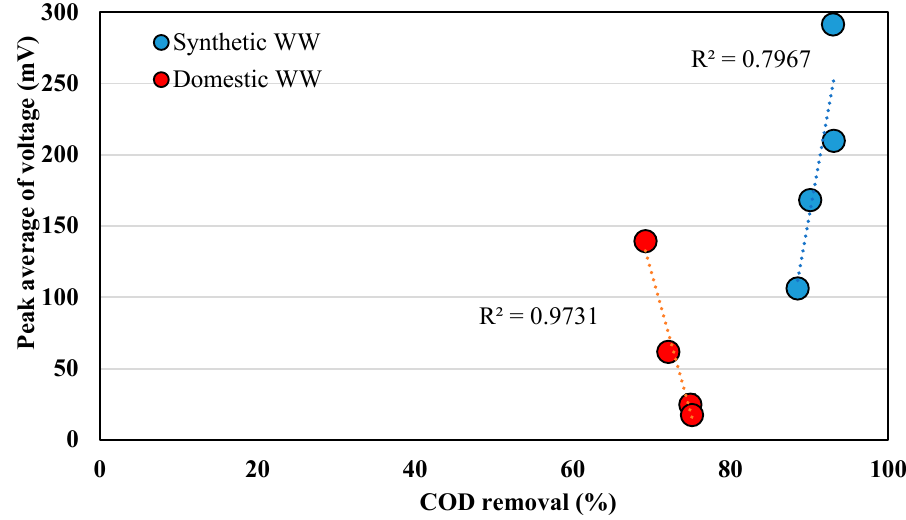
Figure 4. Correlation between COD removal and peak voltage in EBR treating synthetic (blue) and domestic (red) WW.